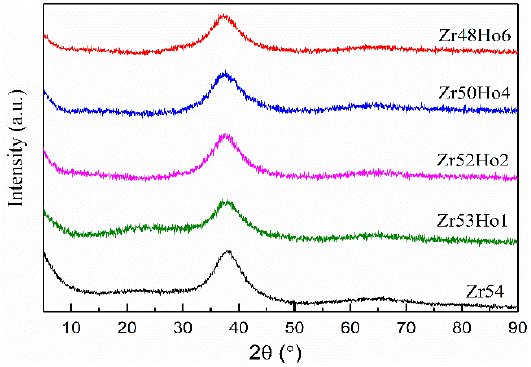
Figure 1. XRD patterns of Zr 54 − x Cu 29 Ni 7 Al 10 Ho x ( x = 0, 1, 2, 4, 6) BMGs.